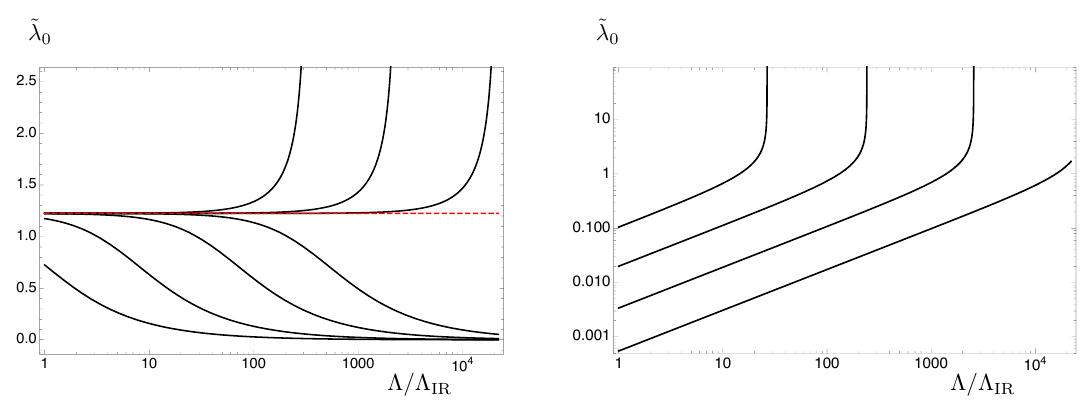
Figure 9 . The coupling ˜ λ 0 as a function of the energy scale Λ for an AdS background. The two panels show a few possible RG flows for the cases of a relevant deformation with ∆ R = 1 . 75 (left), and an irrelevant deformation with ∆ R = 3 . 25 (right). The dashed red line indicates the position of the IR fixed point (left